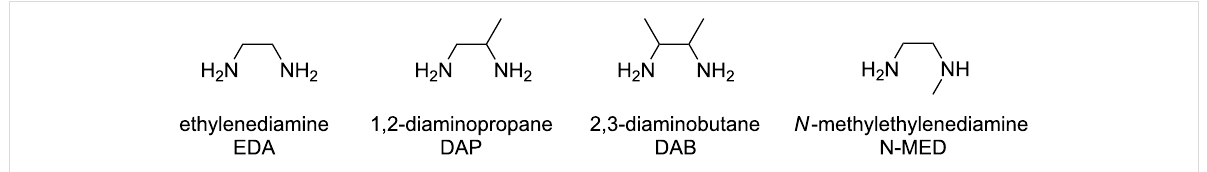
Figure 1: Schematic illustration of applied SCAs containing two vicinal amine groups and different H 3 C-groups.